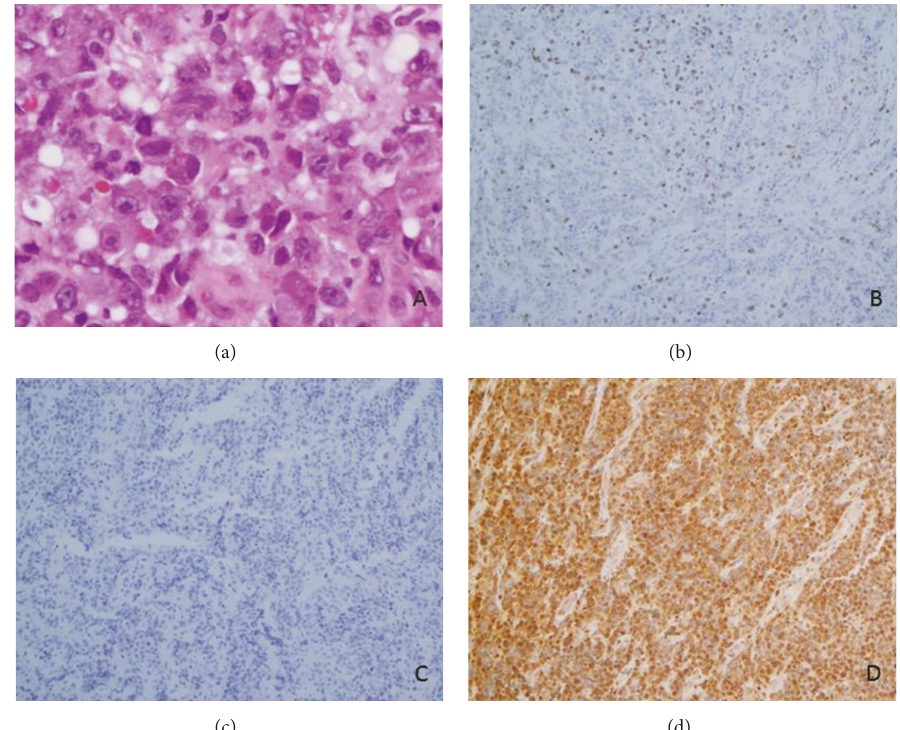
Figure 1: Diffuse lymphoid infiltrates consisting of predominantly large atypical cells with plasmacytic differentiation ((a), H&E, 400x). Immunohistochemistry stains revealed that the tumor is positive for CD138 (d) but negative for CD3 (b) and CD20